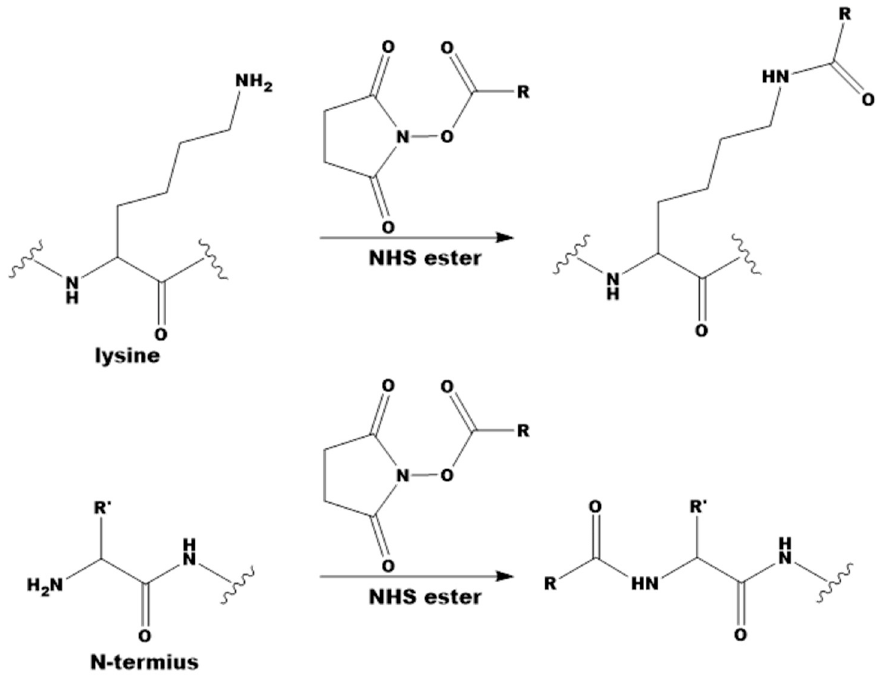
Figure 1. Free amine modifications [16].